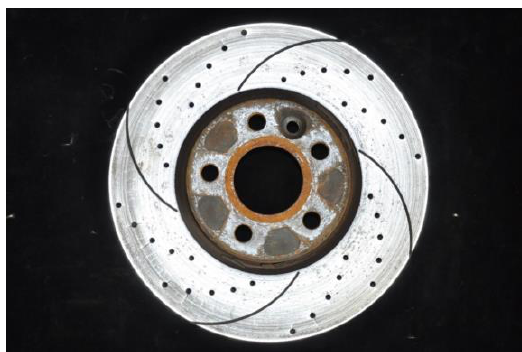
Fig. 3. Macroscopic image of the analyzed brake disc; visible venting and gas removal system through notches and holes distributed in a characteris- tic radial-axial manner; unetched state